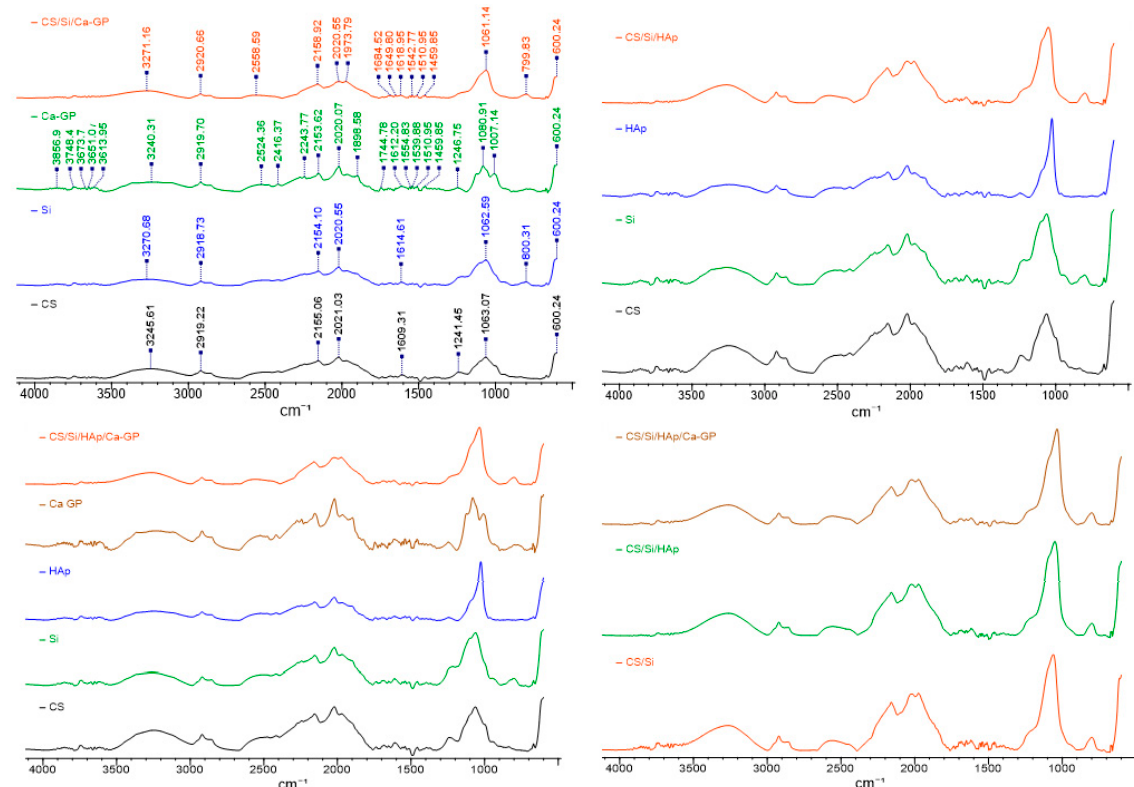
Figure 7. FTIR characterization of implants made of CS/Si/HAp, CS/Si/Ca-GP, CS/Si/HAp/Ca-GP.